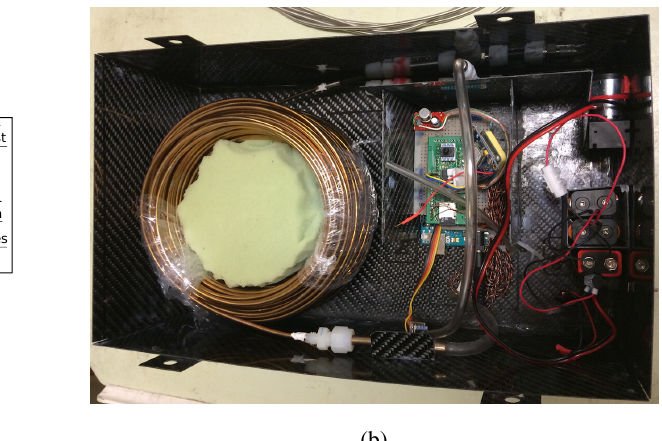
cavity of the analyzer is strictly maintained at a pressure of ∼ 186 hPa (140 Torr) and a temperature of 45 ◦ C to achieve a precision (1 σ , 0.5 Hz) better than 0.03 ppm for CO 2 , 0.5